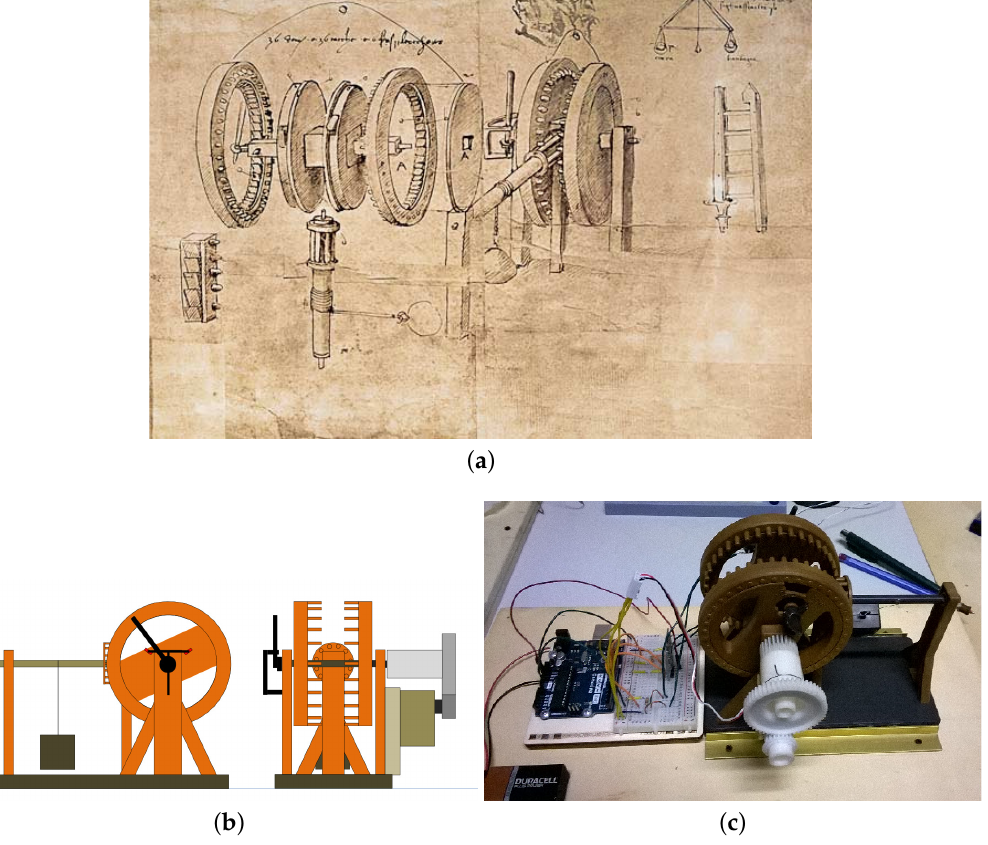
Figure 3. Machine 3, the Lever Crane: original sketches of lever crane ( a ); scheme of the automated setup ( b ); picture of the automated Lever crane system ( c